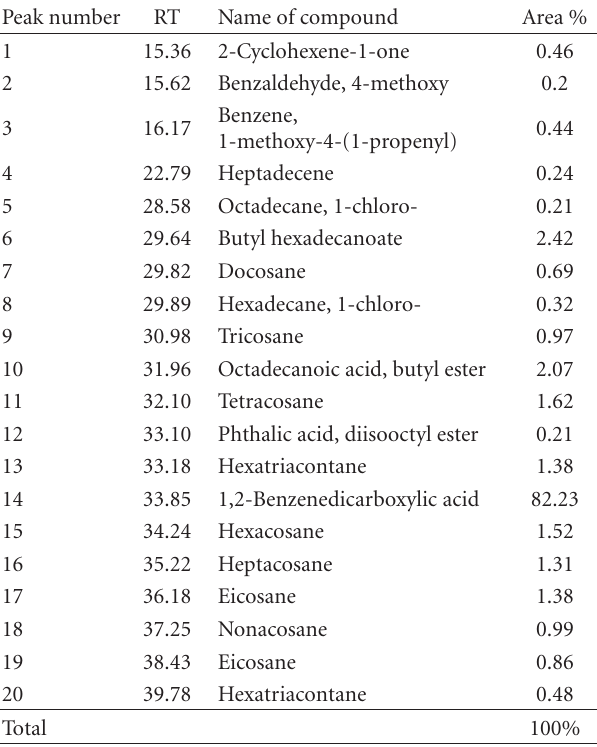
Table 8: Essential oil constituents of E. compressa .